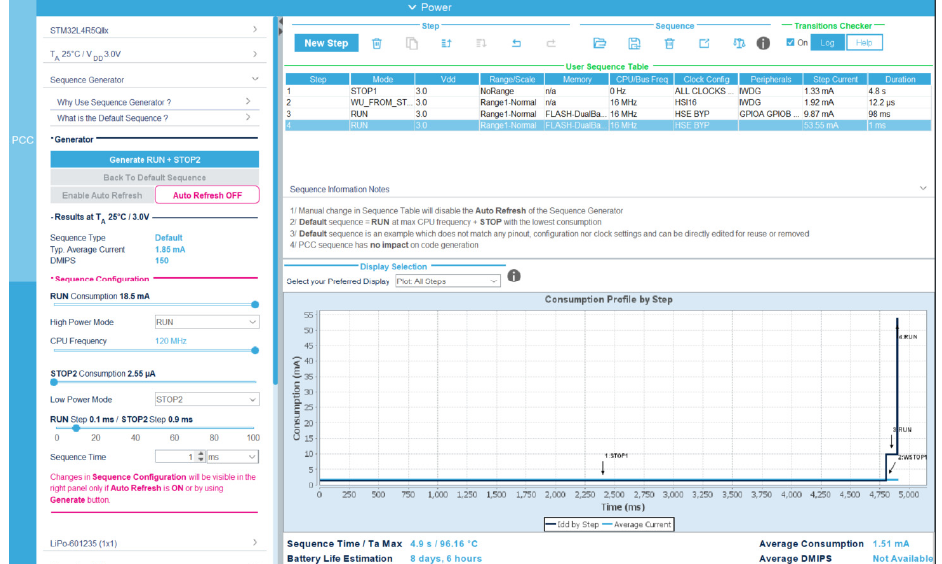
Figure 7. Power consumption profile calculated by STMCubeMX battery life estimator.